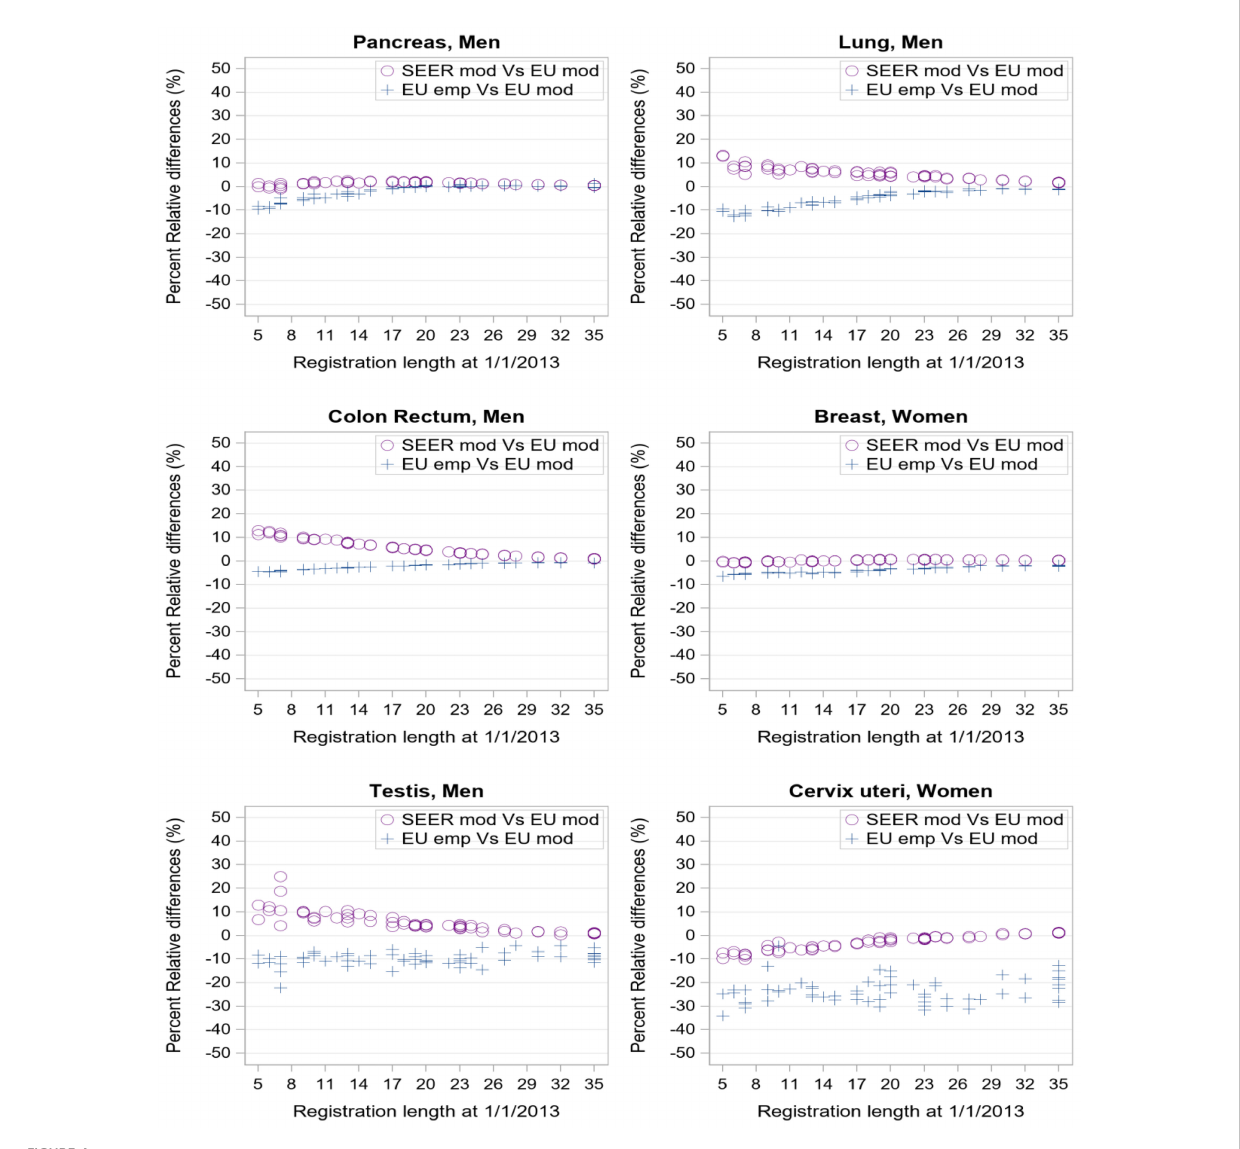
FIGURE 4 Percent relative difference (%) by registration length at 1/1/2013 of complete prevalence estimates obtained with SEER model-based or EU empirical R-index against EU model-based estimate as reference value. Each point corresponds to one of the 62 registries in dataset d of Table